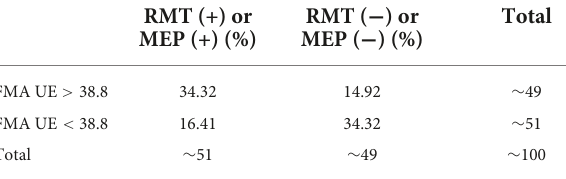
TABLE 2 Frequency contingency table of FMA UE scores and RMT (+) or MEP (+). RMT (+) or RMT ( − ) or Total MEP (+) (%) MEP ( − ) (%) FMA UE > 38.8 34.32 14.92 ∼ 49 FMA UE < 38.8 16.41 34.32 ∼ 51 Total ∼ 51 ∼ 49 ∼ 100 FMA UE (max 66), Fugl-Meyer Upper Extremity; MEP (+), Motor Evoked Potential present; MEP ( − ), Motor Evoked Potential absent; RMT (+), Resting Motor